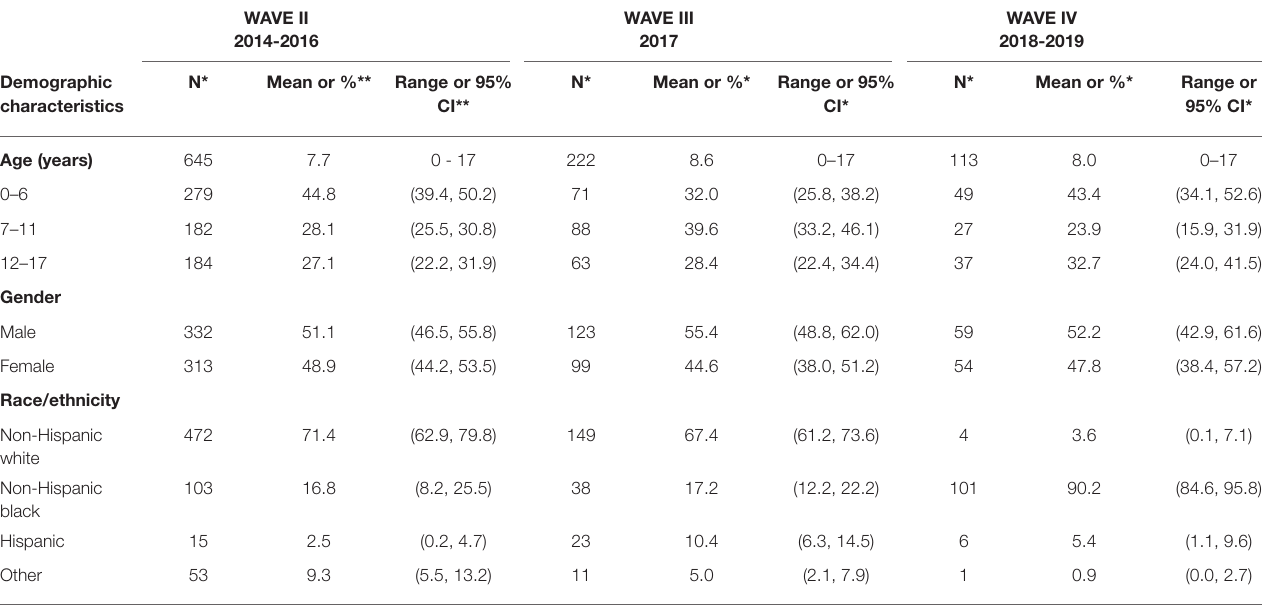
TABLE 2C | SHOW children in WAVES II, III and IV characteristics.